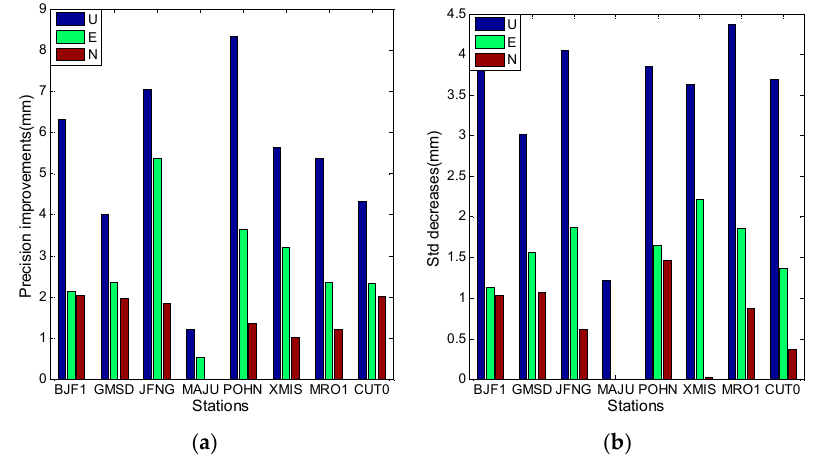
Figure 23. The kinematic PPP results using ionosphere-free combination of the first and second frequencies. ( a ) Describes the precision improvements after the model is applied; ( b ) Describes the Std decreases after the model is applied.